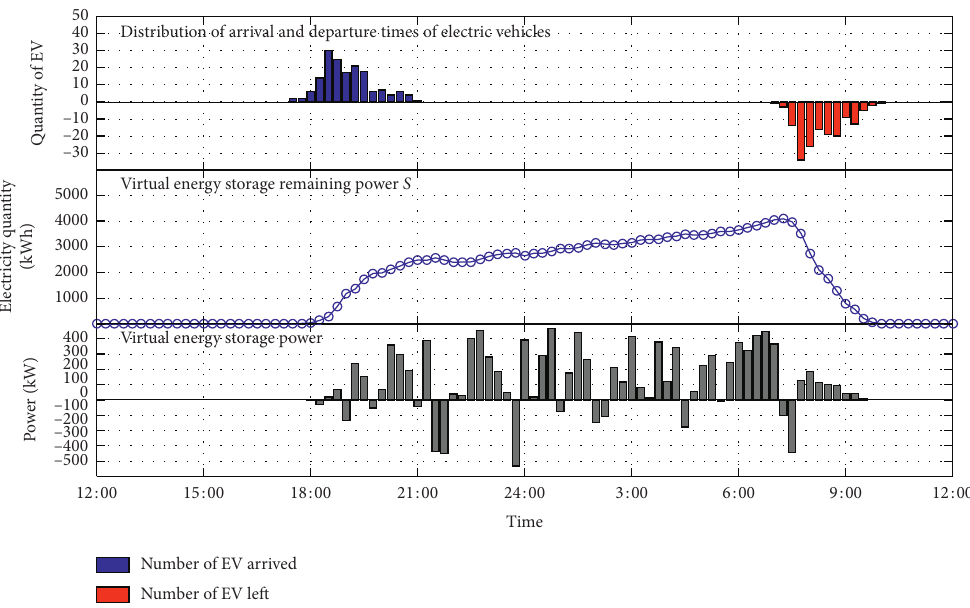
Figure 12: Comparison chart of electric vehicle’s space-time distribution, remaining power, and